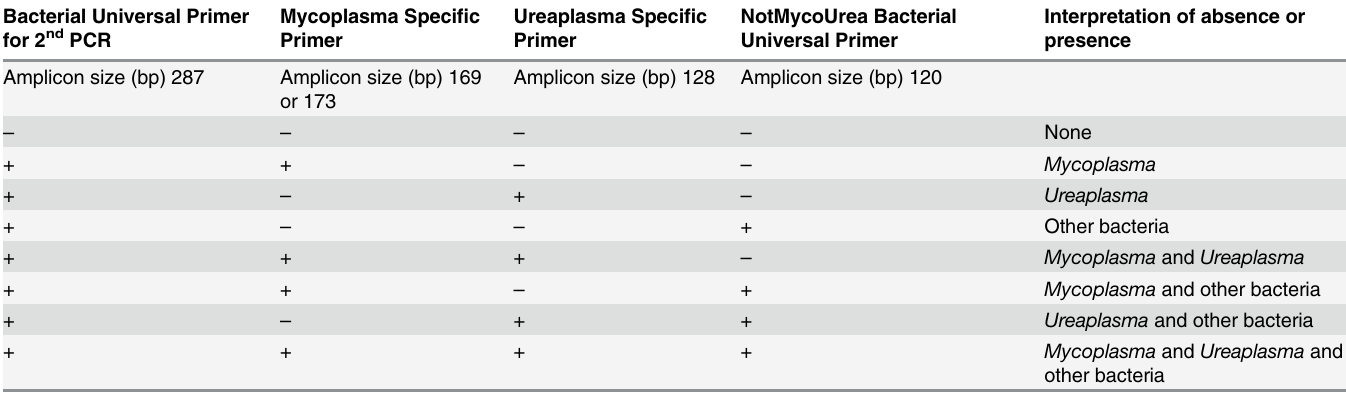
Table 2. Interpretation scheme for the absence or presence of Mycoplasma , Ureaplasma , and other bacteria in amniotic fluid samples. Bacterial Universal Primer for 2 nd